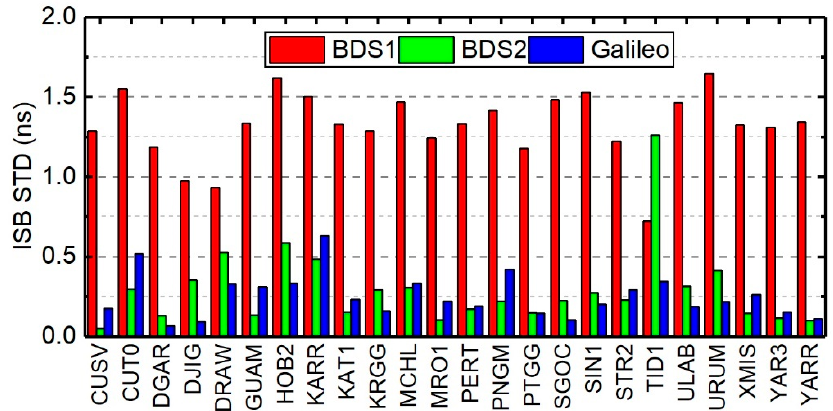
Figure 5. STD of each station’s one day (3 September 2019) ISB series for BDS-2 and Galileo. The STD of the original ISB series for BDS-2 is marked as “BDS1”, and the new solution with the variation trend removed is marked as “BDS2.”.